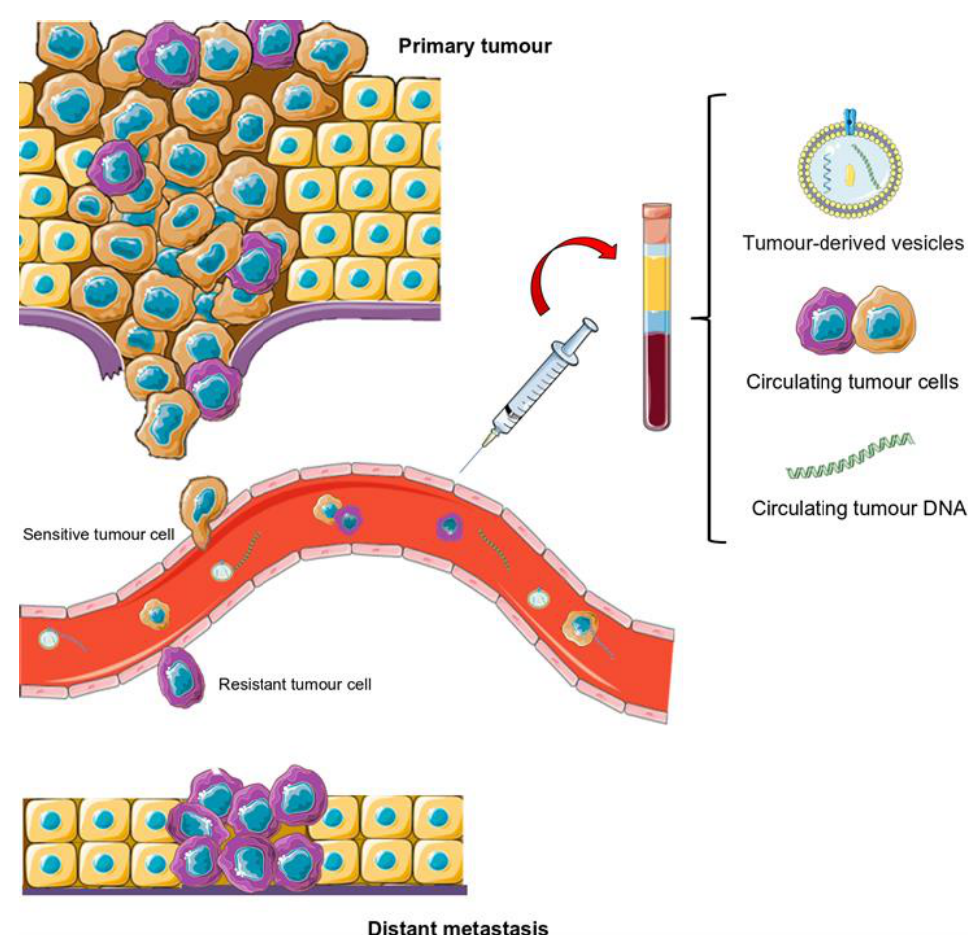
Figure 2. Scheme of metastatic progression and potential use of liquid biopsy. In the bloodstream, there are different circulating tumour cell (CTC) subpopulations. Those that have survived the therapy and become resistant are responsible for the recurrence and progression of the disease to distal locations. Liquid biopsy permits the sampling of these and other tumour entities, such as circulating tumour DNA (ctDNA) or extracellular vesicles. As such, serial liquid biopsy throughout therapy is useful for studying the appearance of treatment resistance.